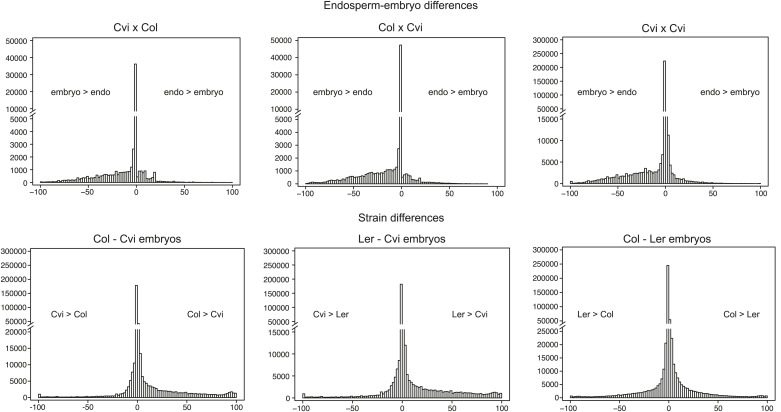
Distribution of endosperm-embryo and strain CG DNA methylation differences.Histograms showing the distribution of all the 300 nt comparisons irrespective of the associated p-value. x axis: difference in weighted methylation; y axis: number of windows.